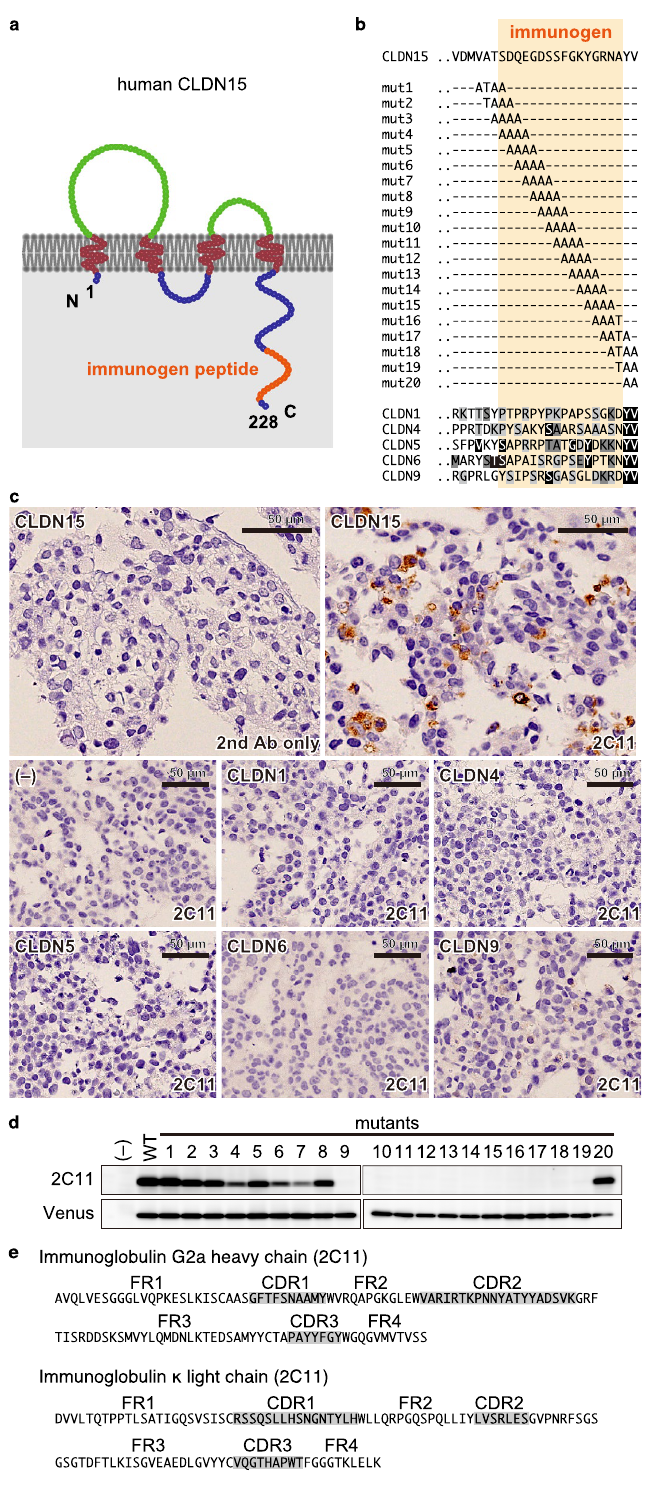
Figure 2. Establishment of a novel anti-CLDN15 mAb suitable for IHCs. a Schematic representation of the domain structure of human CLDN15 protein. The region corresponding to the peptide used for the immunization is shown in orange. b Amino-acid sequence of the cytoplasmic tail of CLDN15 and alanine mutants used in this study. Alignment with other CLDNs is also shown. c IHC of HEK293T cells expressing CLDNs. Note that 2C11 specifically stains only CLDN15-expressing cells. d Epitope analysis of 2C11. Note that 2C11 signal is lost in mutants 9–19, indicating that the epitope is 219 FGKYGRNA 226 of CLDN15. e Amino-acid sequences of CDRs of